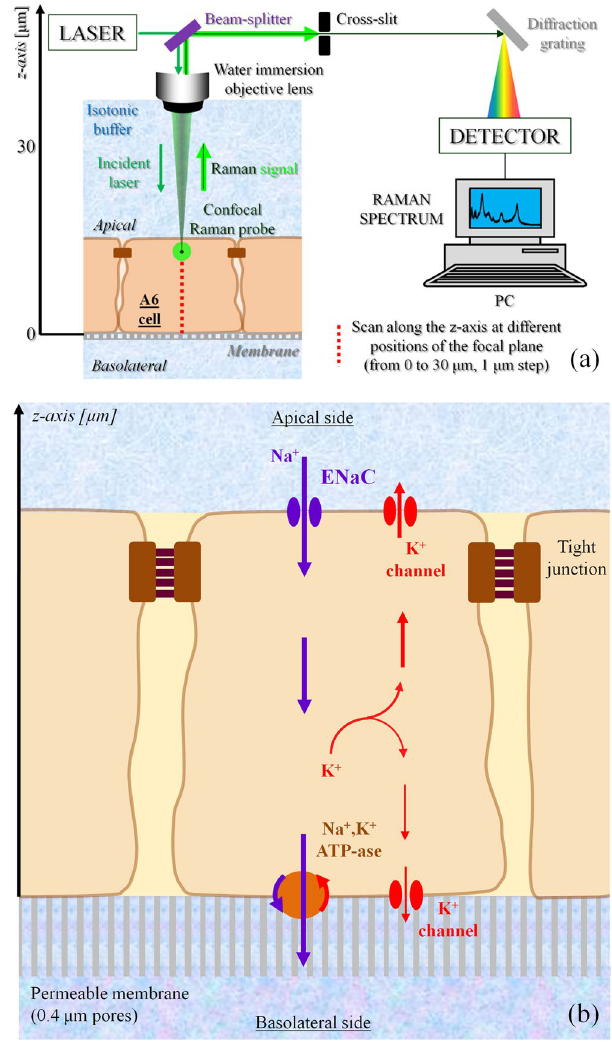
Figure 1. ( a ) Explanation of the z-axis scanning protocol adopted in the Raman spectroscopy experiments. The incident laser and the back-scattered Raman signal collected by the same lens are separated using a beam splitter. The confocal cross-slit enables to increase the spatial resolution of the measurements by cutting off the signal coming from regions that are more than a few hundred of nm out of the focal plane. A diffraction grating is used to split the light into its components, whose intensities are measured by the detector. ( b ) Schematic of the A6 renal epithelial cell under investigation, in which are described the ionic transport mechanism of sodium